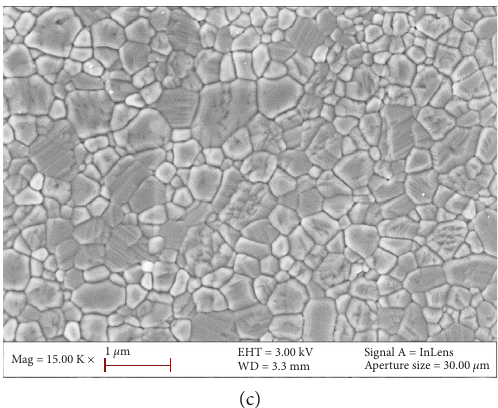
2 O 4 square shape samples, (b) photograph